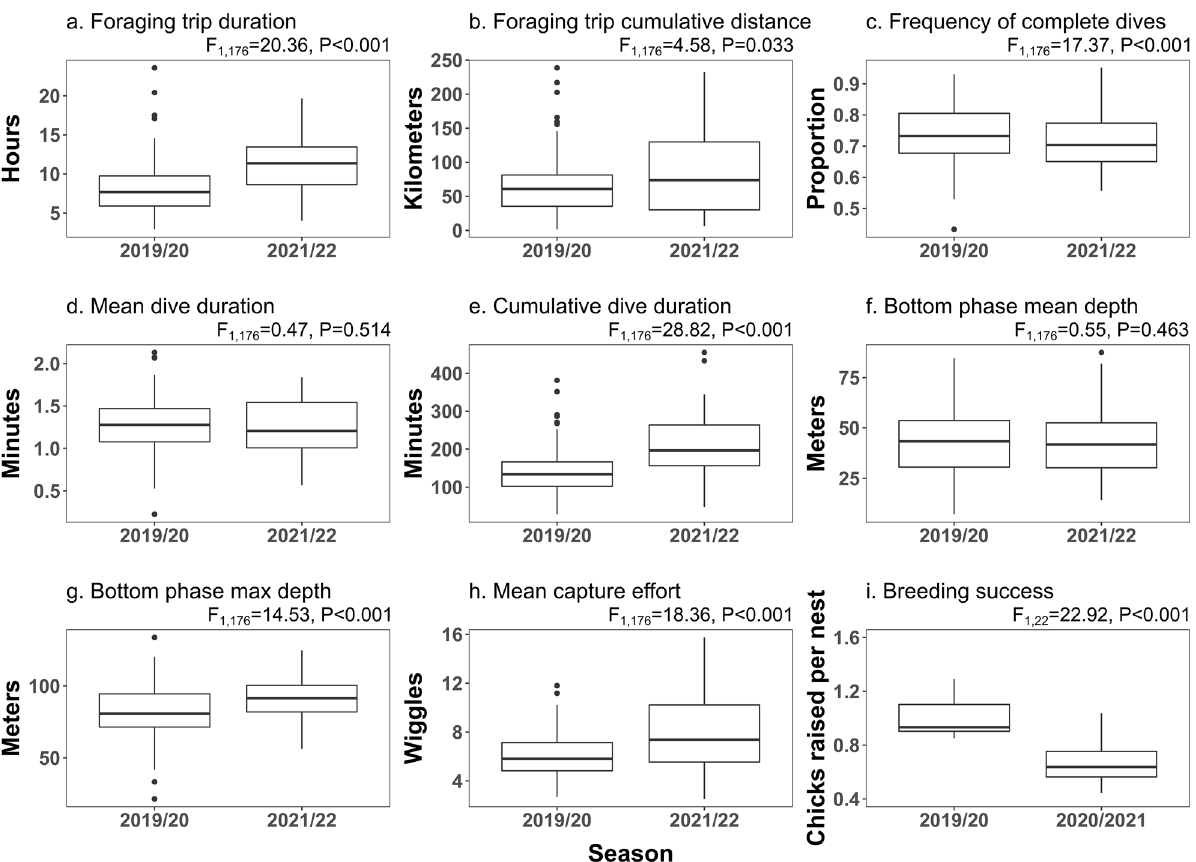
Permutational Analysis of Variance (999